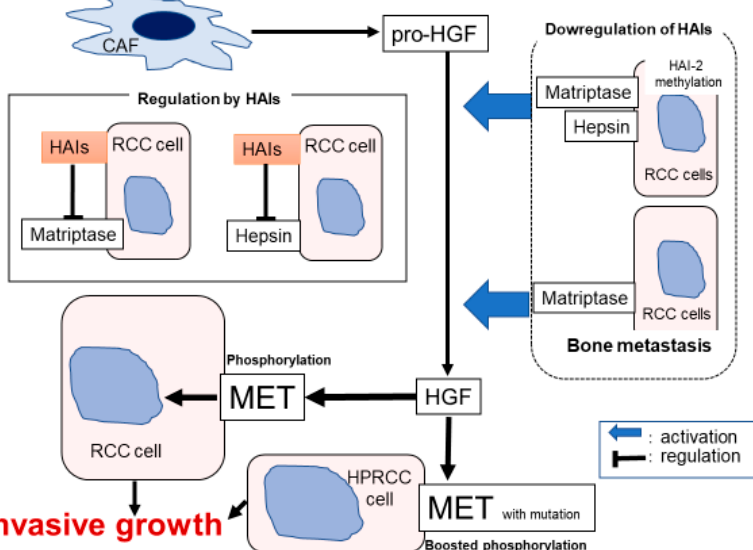
Figure 5. Hypothetical model of pericellular activation of pro-HGF in renal cell carcinoma (RCC) is shown. Downregulation of HAIs including HAI-2 methylation induced overactivation of matriptase and hepsin. In bone metastasis, increased expression of matriptase and downregulation of HAI-2 leads to the upregulation of HGF activation. In addition, phosphorylation of MET with auto-activating mutation was enhanced by HGF stimulation.